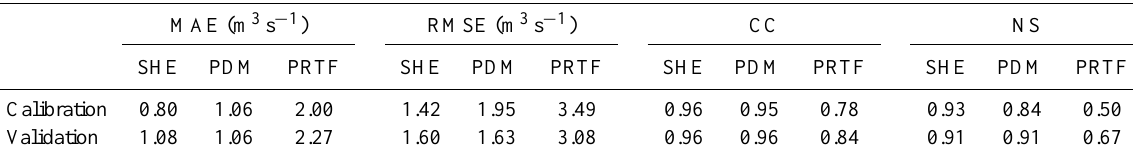
Table 1. Statistics of performance for model calibration and validation.